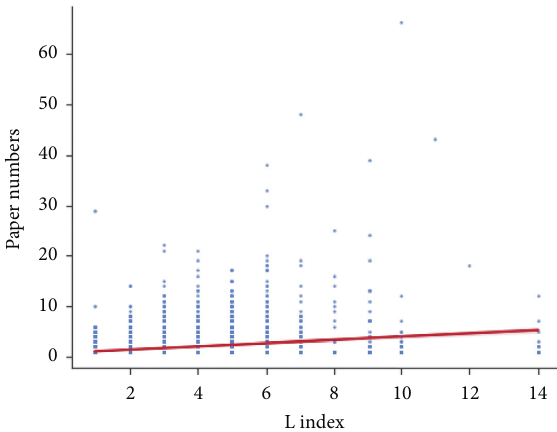
Figure 9: Scatter diagram and regression curve of correlation between the number of papers and